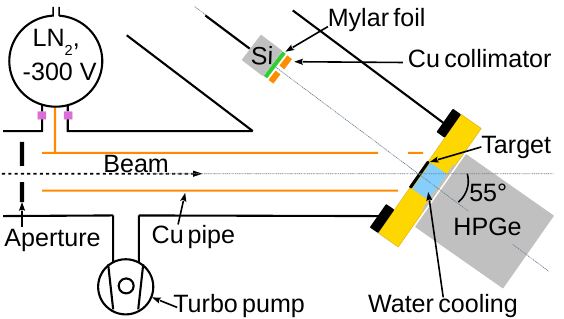
Figure 1: Sketch of the experimental setup used for the measurement of the 6 Li(p, γ ) 7 Be cross section at LUNA